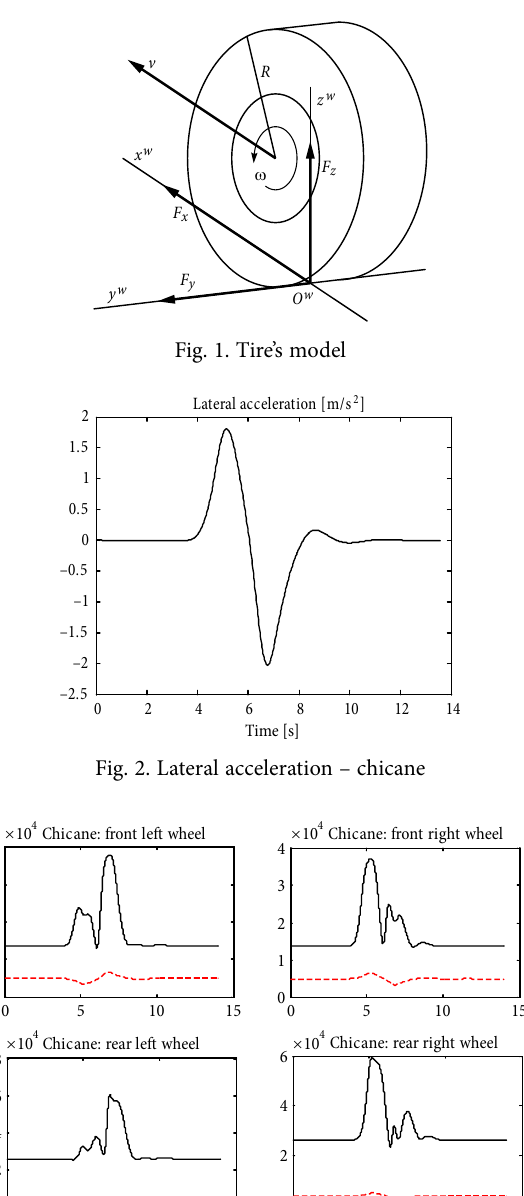
Fig. 1. Tire’s model